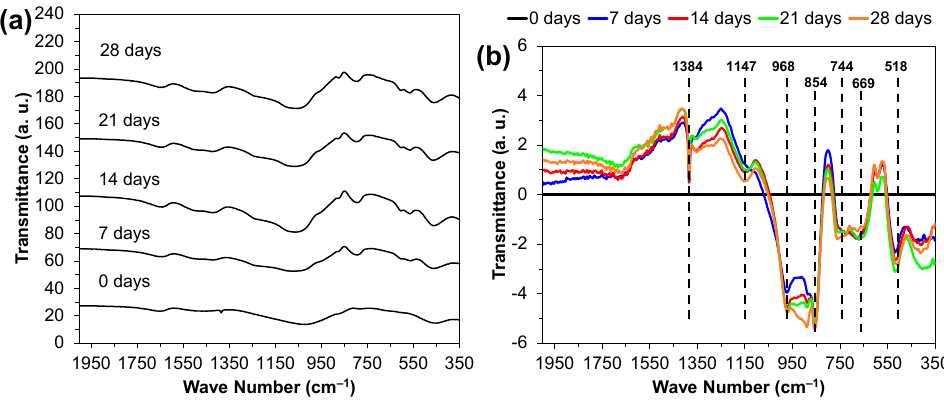
Figure 8. ( a ) FTIR spectra for powders that were calcined at 600 °C before immersion in SBF for different durations; ( b ) FTIR spectra with the 0-day sample baseline subtracted.